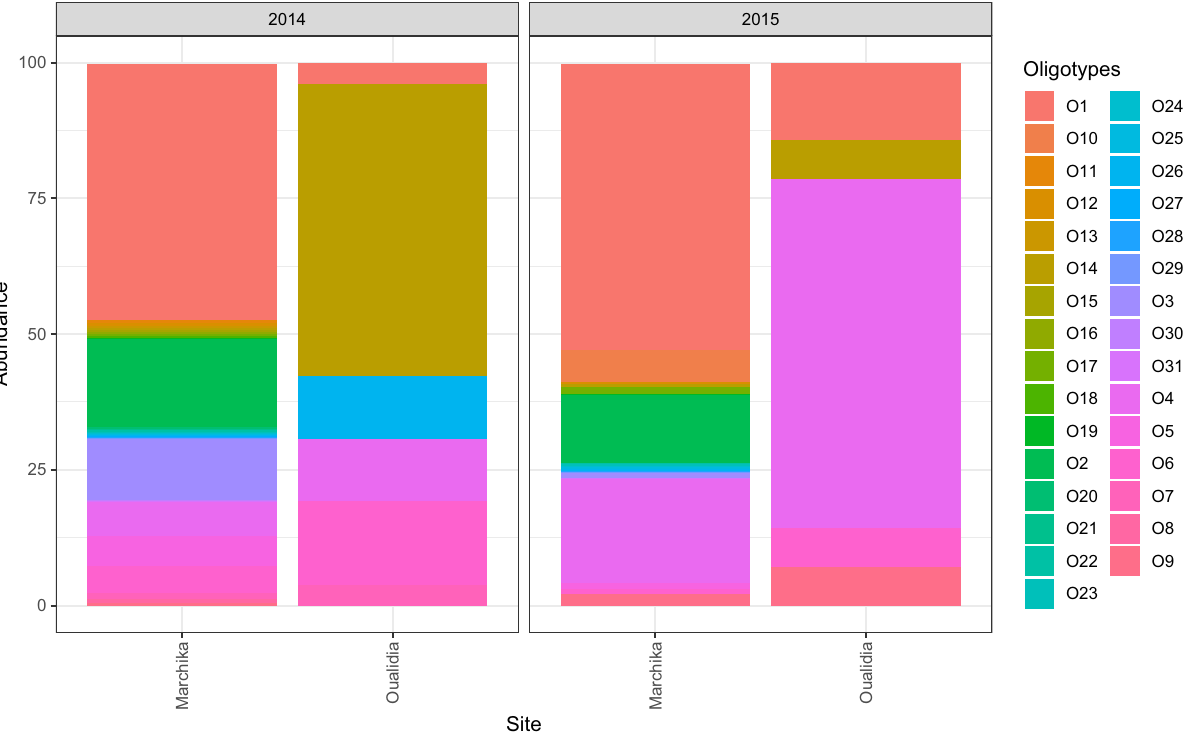
Figure 1. Cross comparison of 31 Synechococcus oligotypes in Marchica and Oualidia lagoons in 2014 and